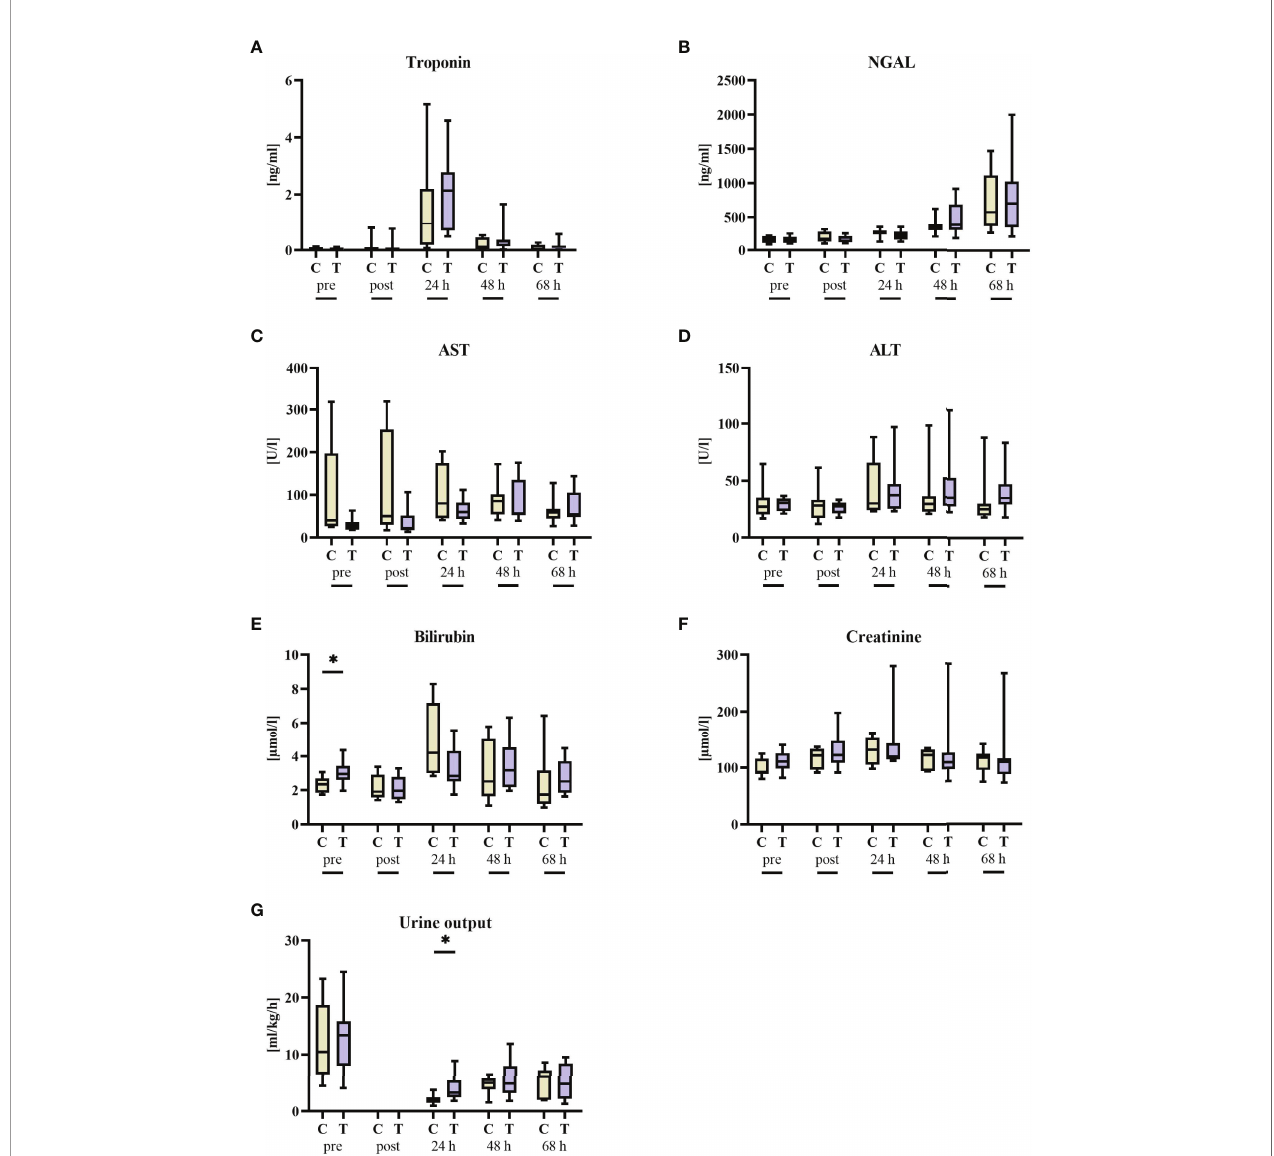
FIGURE 3 | Organ function parameters before (pre) and after 3 h of hemorrhagic shock (post) as well as 24 h, 48 h, and 68 h after resuscitation. (A) Troponin, (B) neutrophil gelatinase-associated lipocalin (NGAL), (C) aspartate transaminase (AST), (D) alanine transaminase (ALT), (E) bilirubin, (F) creatinine, and (G) urine output. n = 8/9 before shock, 8/9 after shock, 8/9 at 24 h, 7/9 at 48 h, and 7/8 at 68 h animals per group for vehicle control (yellow, C) and thiosulfate (purple, T), respectively. * = p < 0.05, Mann-Whitney U test. Box plots report median, interquartile range, minimum, and